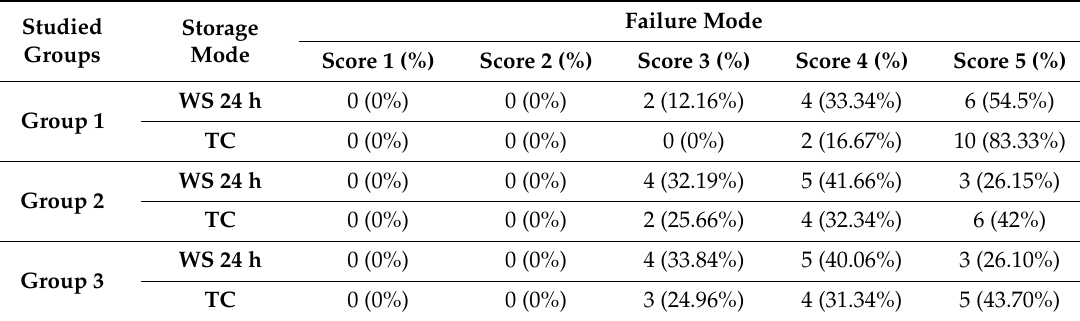
Table 2. Frequencies and percentages of failure mode observed under stereomicroscope 20 ×